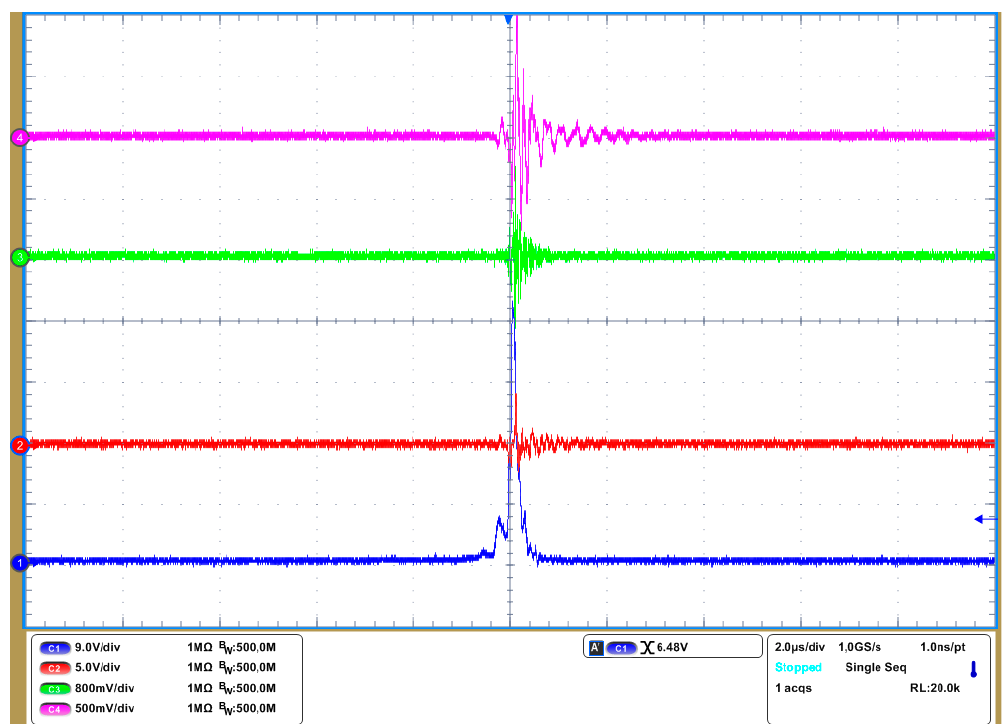
Figure 10. Characteristic oscillogram of the current pulse (blue signal) of the main discharge stage with participation of only the lower group of model hydrometeors and signals, registered by antennas A1–A3 (red, green and magenta signals resp.).